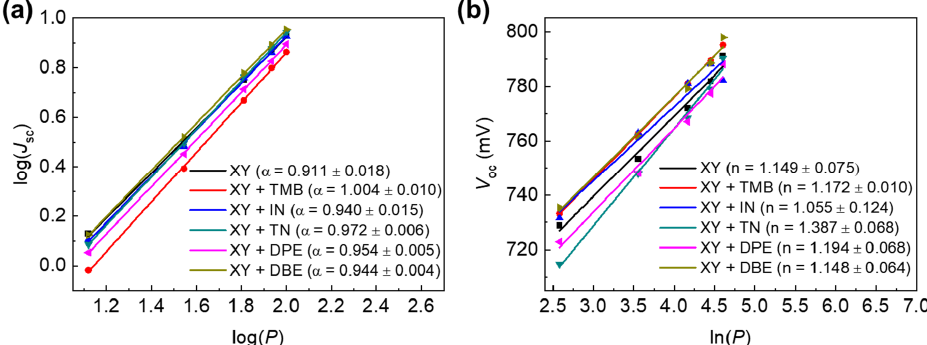
Figure 5. ( a ) J sc − P and ( b ) V oc − P plots of APSCs. The morphologies of the polymer blend films were examined by atomic force micros ‐ copy (AFM) and transmission electron microscopy (TEM). Figure 6 shows the AFM to ‐ pography images of PTB7 ‐ Th:PNDI2HD ‐ T blend films spin ‐ coated with six different so ‐ lutions. Among the XY ‐ based films, those with DPE were the smoothest and had the smallest domain size. The root mean square (RMS) values of surface roughness were 1.85, 3.14, 2.13, 1.04, 0.87, and 1.56 nm for XY ‐ , XY + TMB ‐ , XY + IN ‐ , XY + TN ‐ , XY + DPE ‐ , and XY + DBE ‐ based films, respectively. The results were well correlated with the photovoltaic performance; high ‐ performance XY + TN ‐ and XY + DPE ‐ based films were smooth, whereas poorly performing XY + TMB ‐ and XY + IN ‐ based films were rough. Figure 6. AFM topography images of ( a ) XY ‐ , ( b ) XY + TMB ‐ , ( c ) XY + IN ‐ , ( d ) XY + TN ‐ , ( e ) XY + DPE ‐ , and ( f ) XY + DBE ‐ based blend films. Figure 7 shows the TEM images of PTB7 ‐ Th:PNDI2HD ‐ T blend films. The features of TEM images were similar to those of AFM topography images. XY ‐ , XY + TMB ‐ , XY + IN ‐ , and XY + DBE ‐ based films showed a largely aggregated phase. In contrast, XY + TN ‐ and